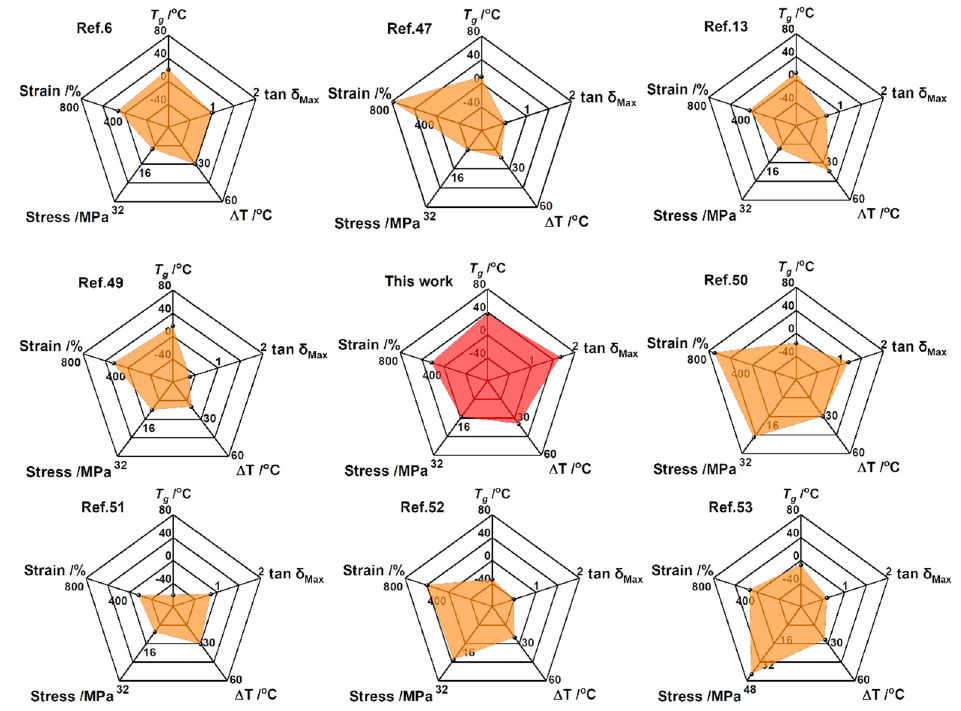
Figure 7. Damping and mechanical properties of different polyurethanes.